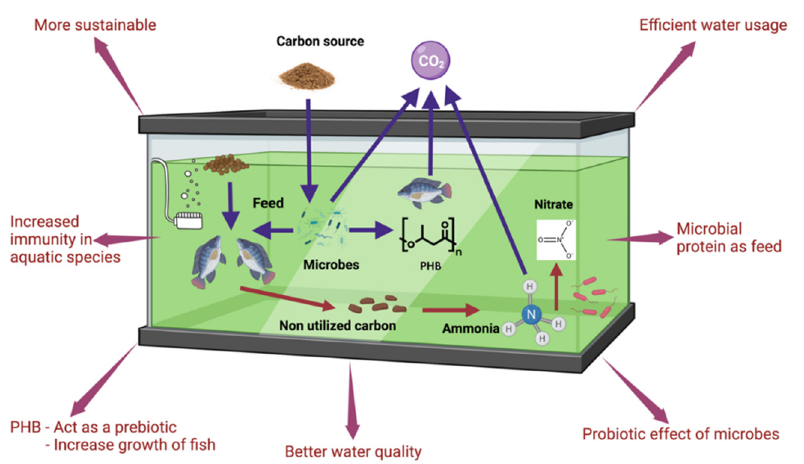
Figure 1. Overview of the inputs and outputs of a generalized biofloc system.